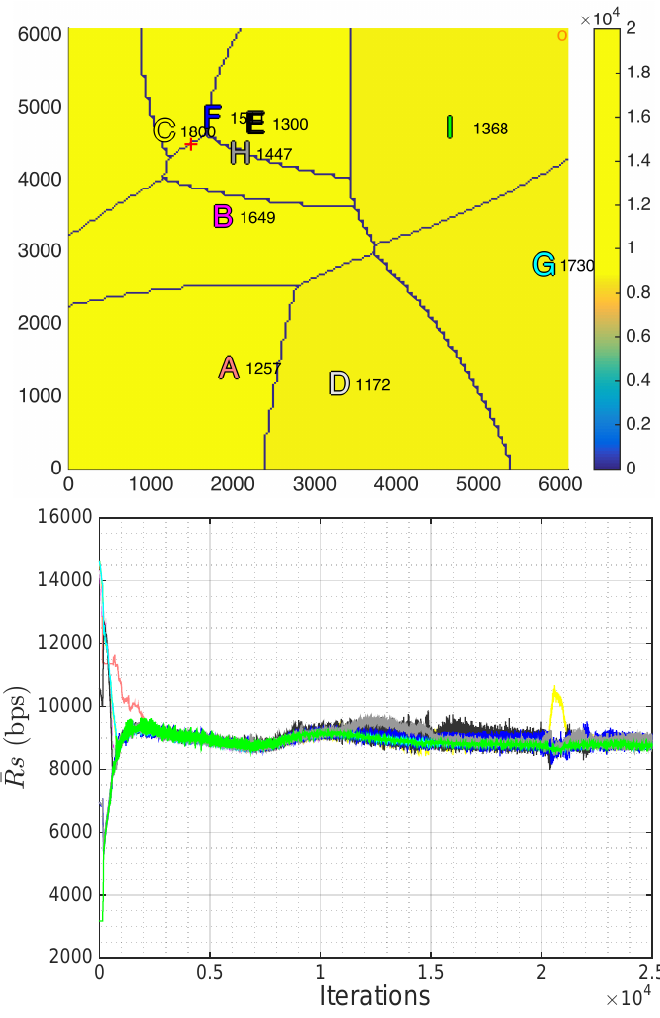
Figure 7. Rearrangement of UAVs when subscribers move: positions and coverage areas ( top ); and evolution of the rate per user in each coverage area ( bottom ). Each color in the bottom figure represents one coverage area using the same colors as the ones assigned to letters in the top